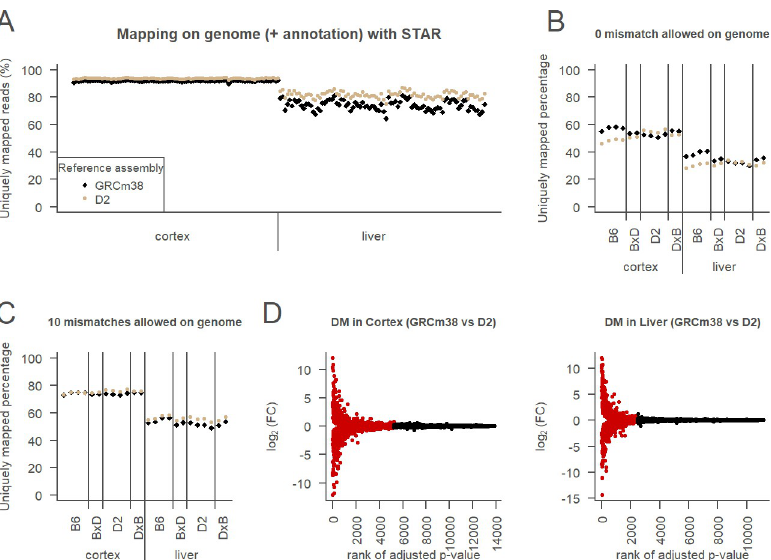
Fig 2. Two parental assemblies strategy. A. Mappability of all samples on 2 parental assemblies (samples are mapped on GRCm38: black symbols and on D2 assembly: brown symbols) using permissive mapping setting (STAR default) in cortex (left) and liver (right). Mappability was estimated as the number of uniquely mapped reads expressed as the % of all reads. B. Mappability in samples from the parental strains and their reciprocal F1 offspring (BxD and DxB) on the 2 parental assemblies using restrictive mapping setting allowing 0 mismatches. Same legend than in A. C. Mappability of parental and F1 samples on 2 parental assemblies using restrictive mapping setting but allowing up to 10 mismatches. Same legend than in A. D. Differential mapping (DM) analysis of D2 assembly compared to GRCm38 in the cortex (left) or in the liver (right). Genes are classified as DM genes if FDR adjusted p-value < 0.05 (red) or non DM genes otherwise